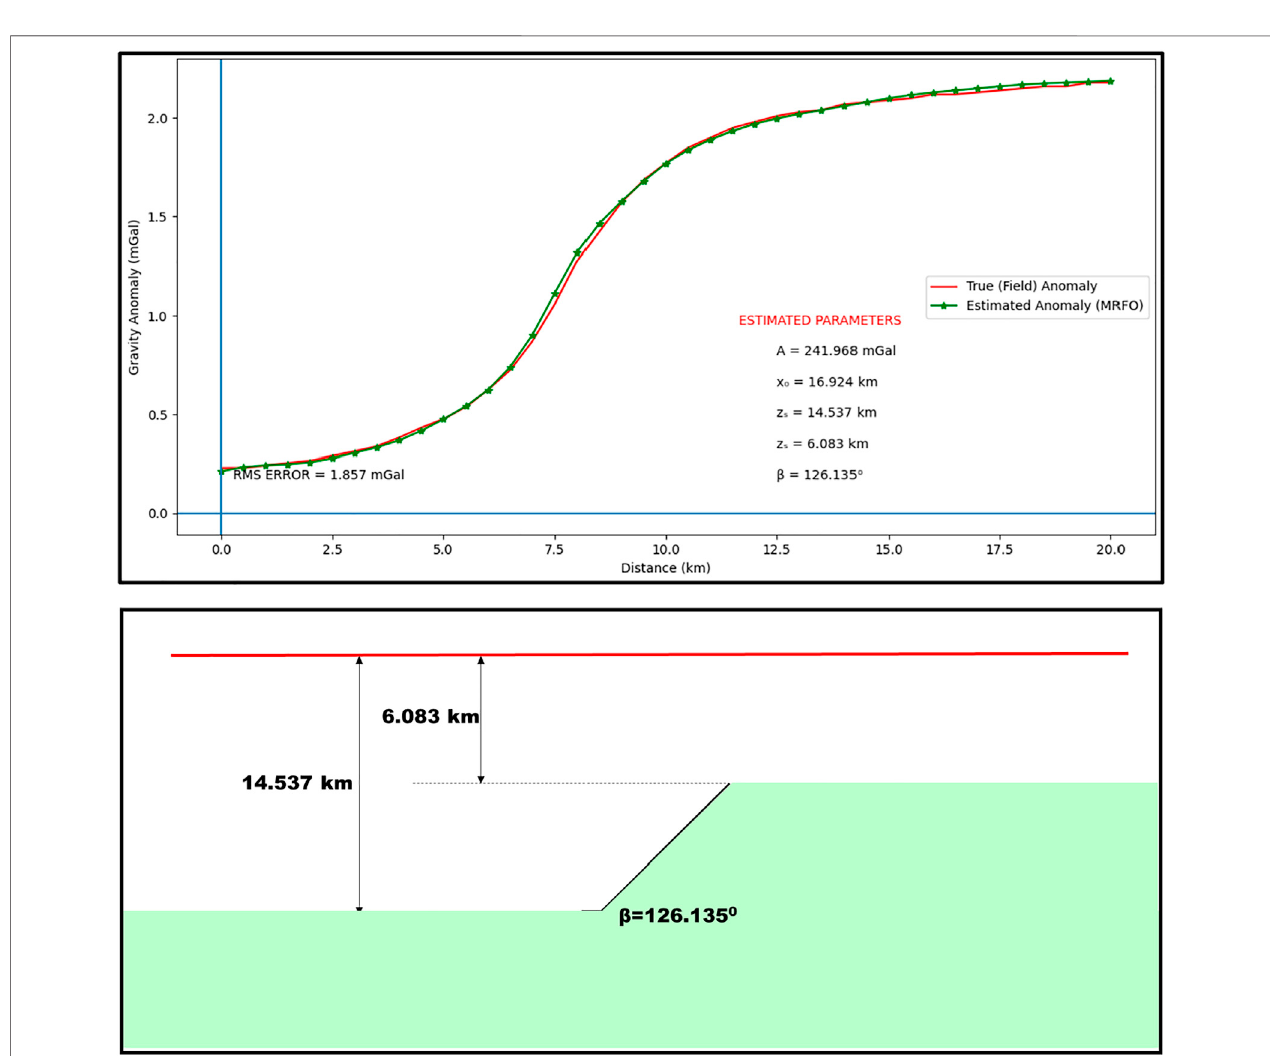
FIGURE 9 | Total gravity anomaly of Garber anomaly, Oklahoma inverted using the MRFO procedure.